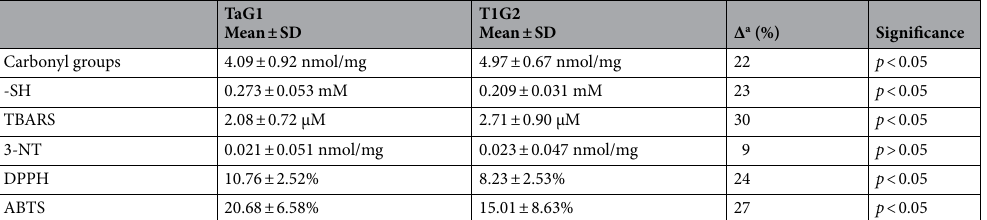
Table 2. The level of oxidative/nitrative stress according to the grades of the disease. a The value expressed as delta represents the percentage level difference for each parameter. The delta value was calculated on the basis of the mean for each of the compared groups.